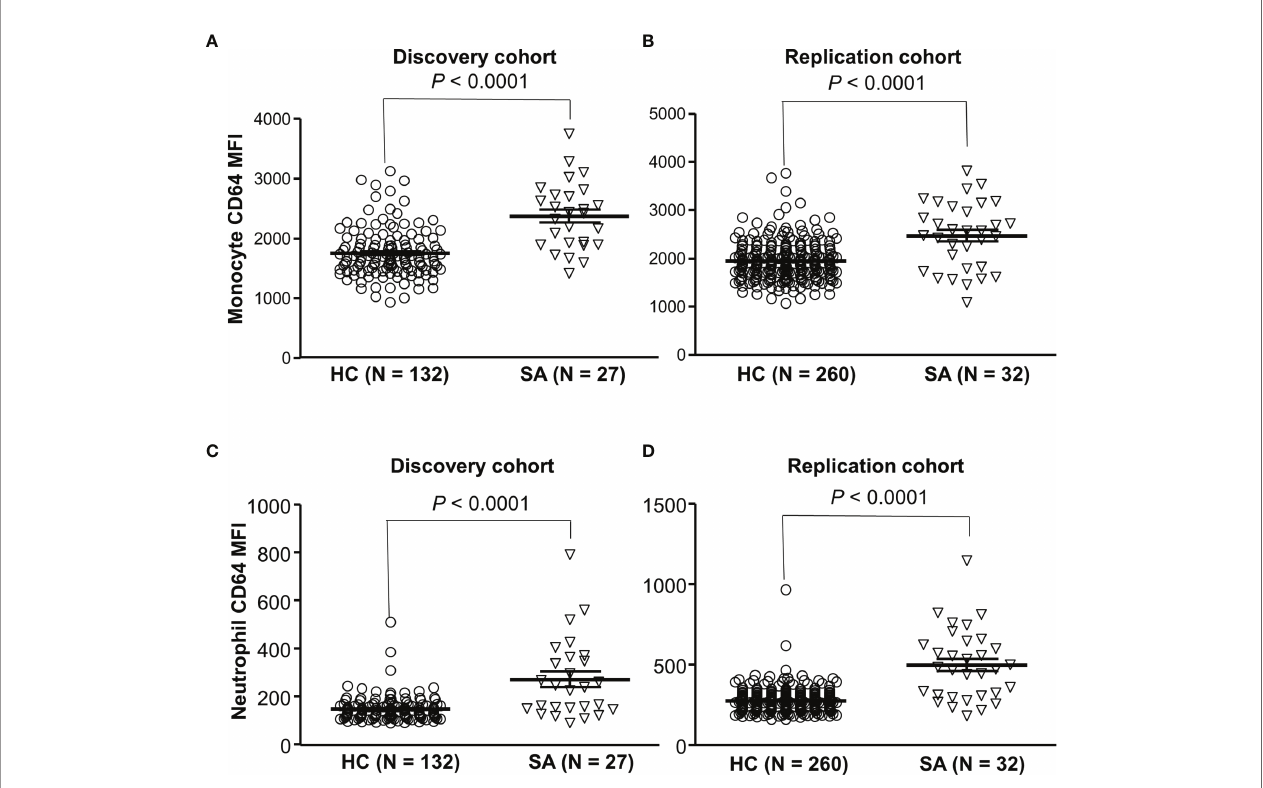
FIGURE 6 | Increased CD64 expressions on monocytes and neutrophils in sarcoidosis patients. Monocytes from sarcoidosis patients (SA) expressed signi fi cantly higher levels of CD64 than those from healthy controls (HC) in both discovery cohort (A) and replication cohort (B) (Mann-Whitney test P < 0.0001). Neutrophils from sarcoidosis patients (SA) expressed signi fi cantly higher levels of CD64 than those from healthy controls (HC) in both discovery cohort (C) and replication cohort (Mann-Whitney test P < 0.0001) (D)